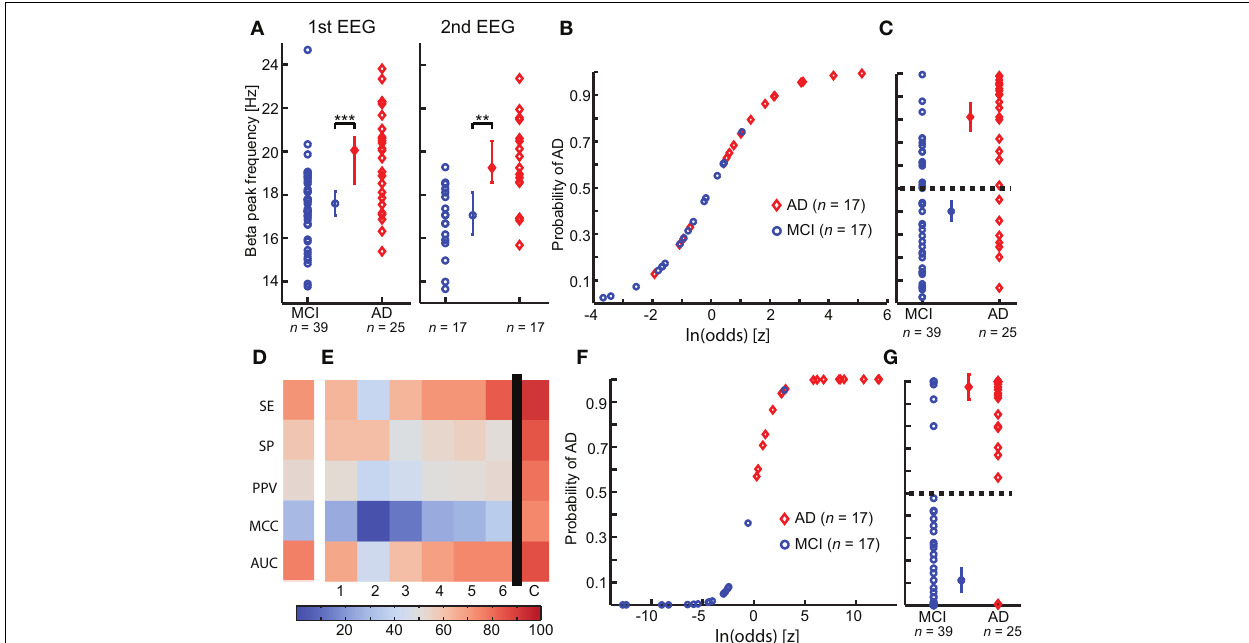
FIGURE 3 | Integration of multiple biomarkers using logistic regression improves the prediction of Alzheimer’s disease at the MCI stage. (A) A significant higher Beta peak frequency is observed in Alzheimer’s disease converter group (AD) (red) compared with mild cognitive impairment stable group (MCI) (blue), in both first (left) and second (right) year EEG recording. (permutation test on median, binomial corrected, ∗∗ p < 0 . 005, ∗∗∗ p < 0 . 0005) ( B) The logistic model is fitted to the second-year EEG recording. (C) The logistic model is used to predict outcome on the first year EEG recording. Separation plot of AD vs. MCI. (D) Outcome evaluation of beta peak frequency using five measures of classification power (warmer is better). SE, Sensitivity; SP, Specificity; PPV, Positive predictive value; MCC, Matthews Correlation Coefficient; AUC, area under the receiver operator curve. (E) Outcome evaluation as in (C) , but for the “optimal” biomarker set found